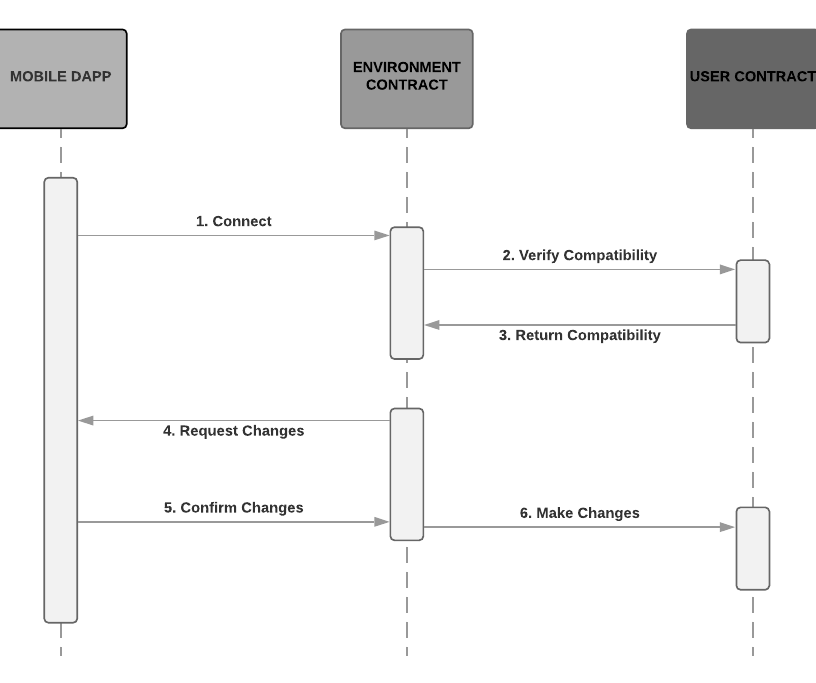
Figure 6. User-Environment communication.